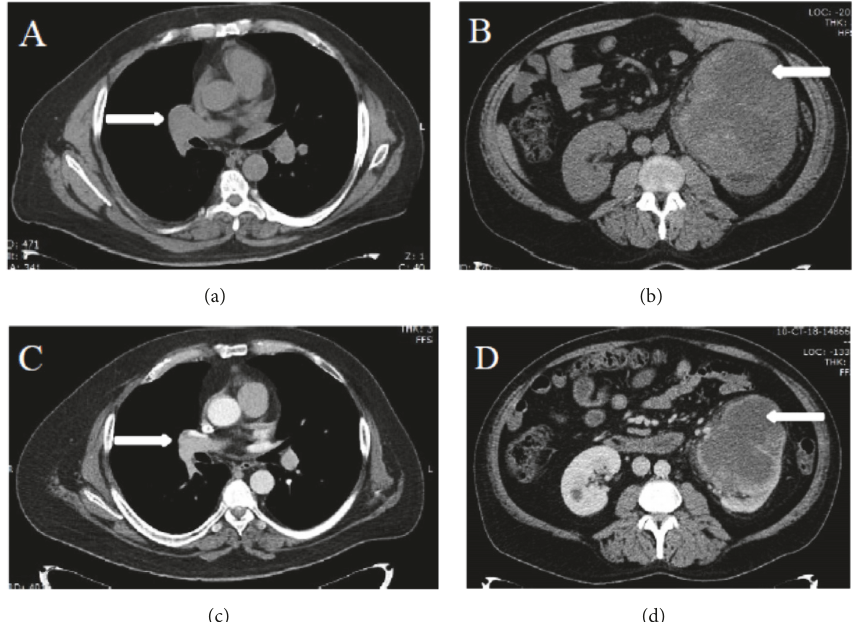
Figure 2: CT CAP . (a) and (b) Axial images of CT CAP showed right sided hilar lymphadenopathy and a large left kidney mass. (c) and (d) Axial images of CT CAP showed improvement in right sided hilar lymphadenopathy and reduction in size of left kidney mass, after 8 weeks of therapy with